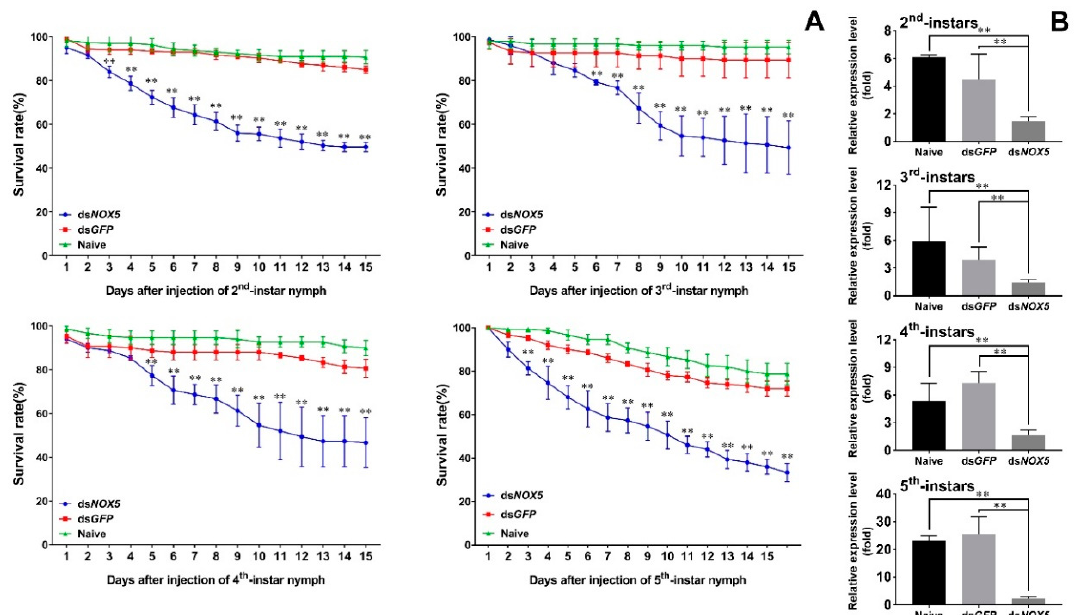
Figure 4. Determination of RNAi e ff ect in N. lugens development. ( A ) Dynamic observation of the survival rates in ds Nox5 -injected N. lugens individuals. The newly hatched 2nd-, 3rd-, 4th- or 5th-instar nymphs were individually injected with ds Nox5 . Non- and ds GFP -treated nymphs were used as controls, respectively. The survival rates were calculated from three biological replicates (mean ± SD). For each treatment, n = 100 nymphs. p < 0.01 was considered statistically significant (**), di ff erent from non- and ds GFP treatments. ( B ) The transcript level variations (in fold change) of Nox5 in 2nd-, 3rd-, 4th- and 5th-instar nymphs were determined by quantitative real-time PCR, as described in Figure 2. Naive and ds GFP refer to non- and ds GFP -treated controls, respectively. The results of triplicate experiments are shown with standard deviations. p values are indicated (Student’s t -test). Asterisks (**) indicate significant di ff erence ( p < 0.01) from